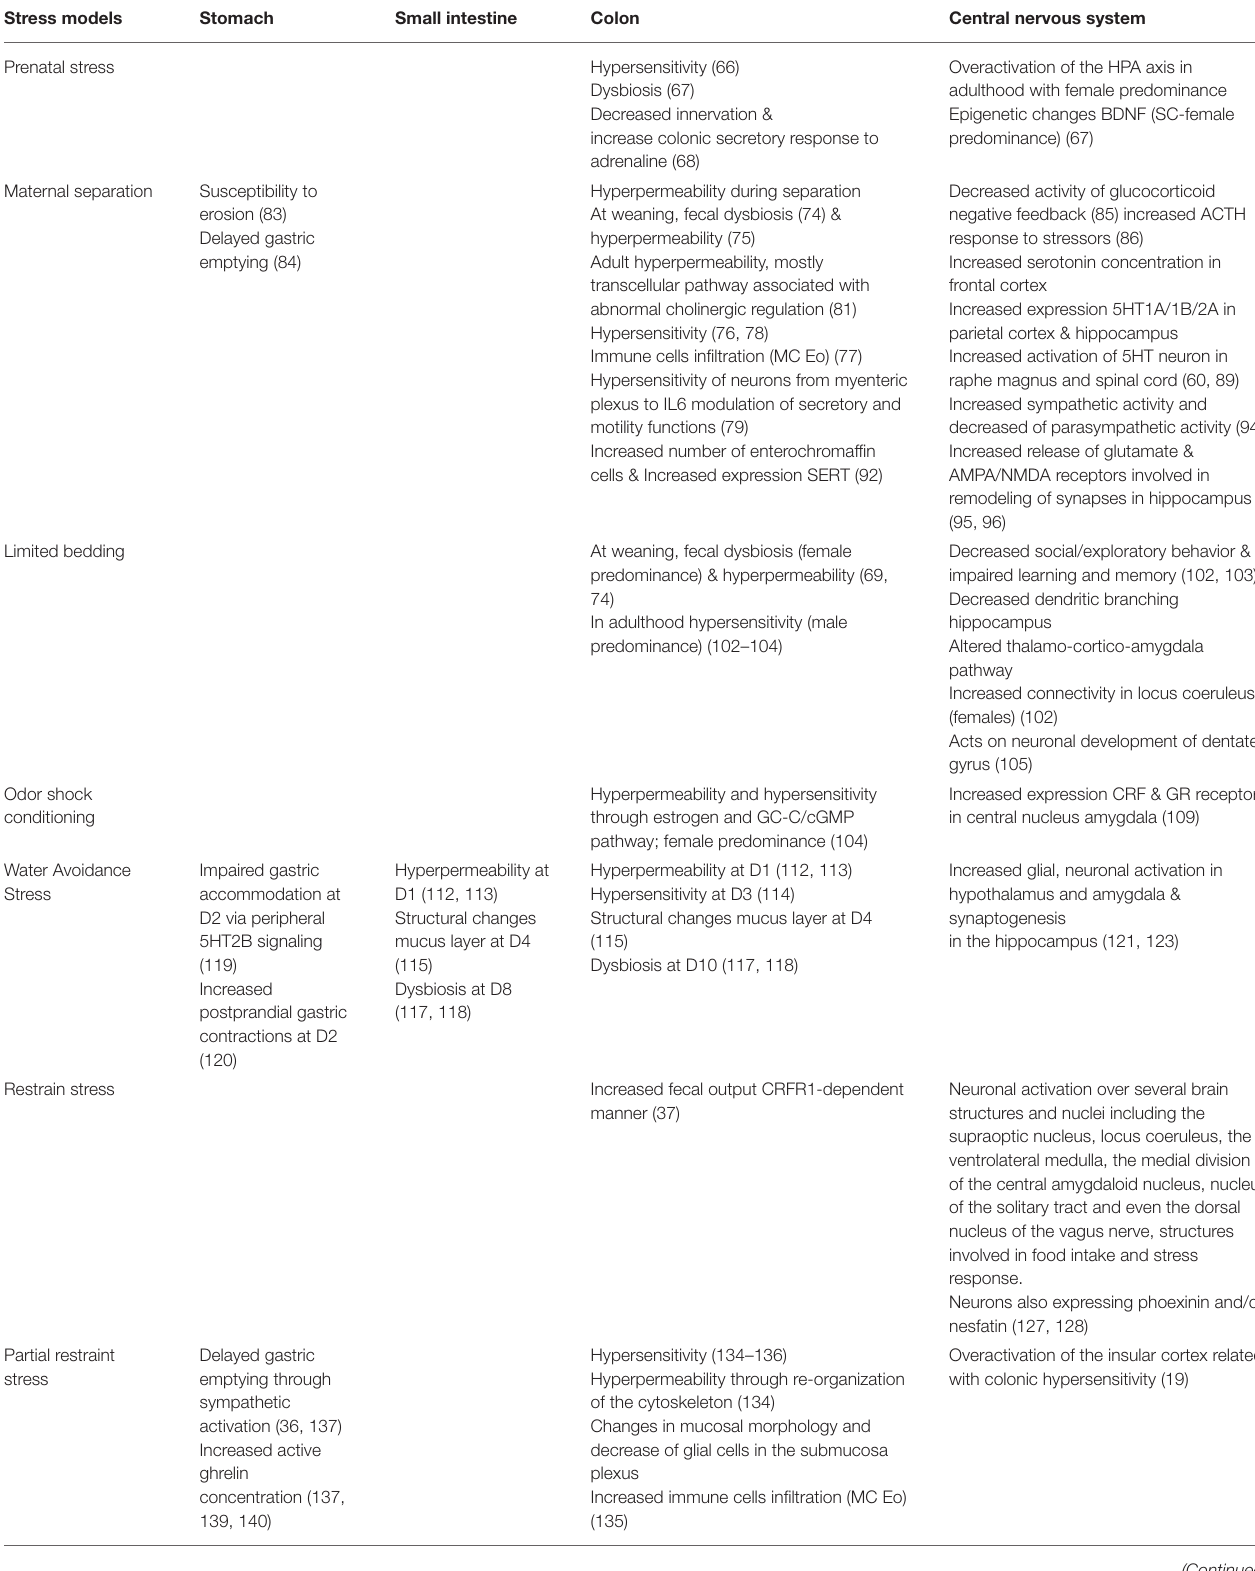
TABLE 1 | Effect of stress on the Gastrointestinal tract and brain in animal